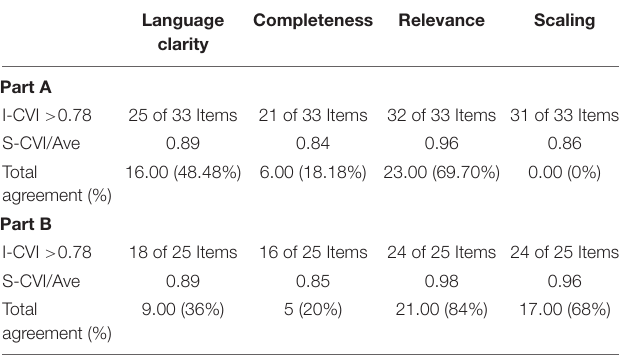
TABLE 5 | Content validity – agreement between members of the expert panel.